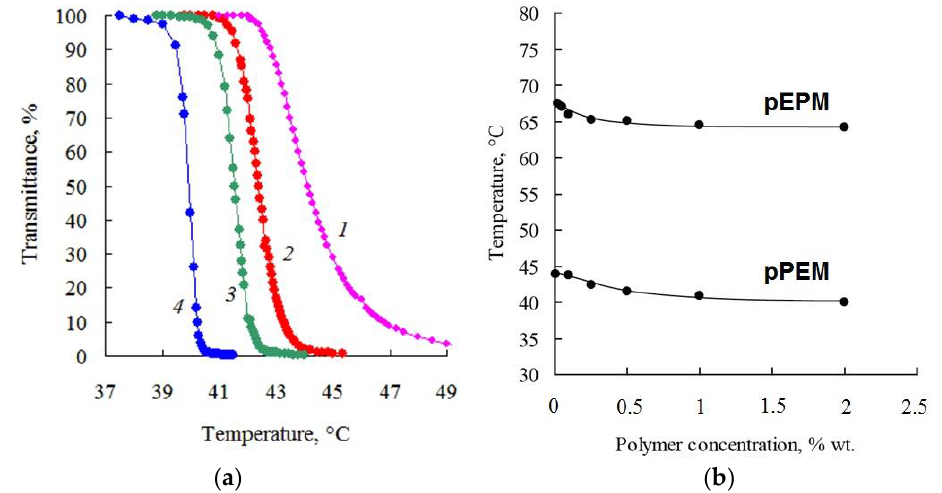
Figure 11. ( a ) Light transmittance vs. temperature at different concentrations of pPEM, %wt.: 0.1 (1), 0.25 (2), 0.5 (3), 2.0 (4); ( b ) Effect of polymer concentration on the Tpt: pEPM (1), pPEM (2).